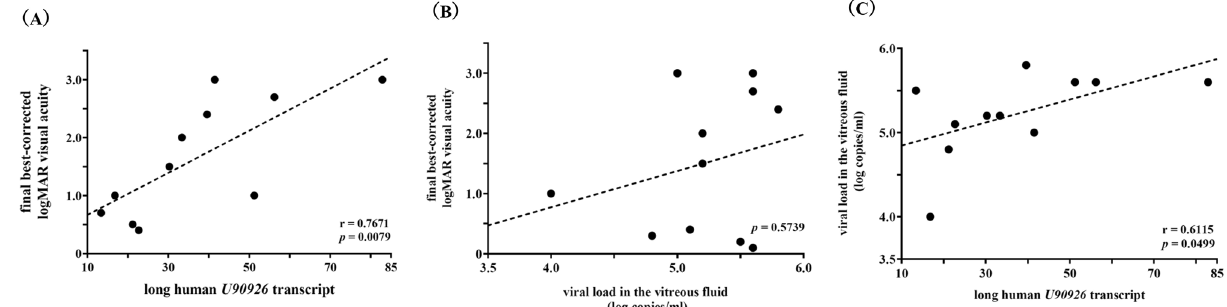
Figure 3. Correlation analyses among the expression of the long human U90926 transcript, viral loads in the vitreous fluid from patients with acute retinal necrosis caused by herpes simplex virus type 1, and the final best-corrected logarithm of the minimum angle of resolution visual acuity in patients with acute retinal necrosis caused by herpes simplex virus type 1. ( A ) Relationship between the expression of the long human U90926 transcript in the vitreous fluid and the final best-corrected logarithm of the minimum angle of resolution (logMAR) visual acuity. ( B ) Relationship between viral loads in the vitreous fluid (log copies/mL) and the final best-corrected logMAR visual acuity. ( C ) Relationship between the expression of the long human U90926 transcript and viral loads (log copies/mL) in the vitreous